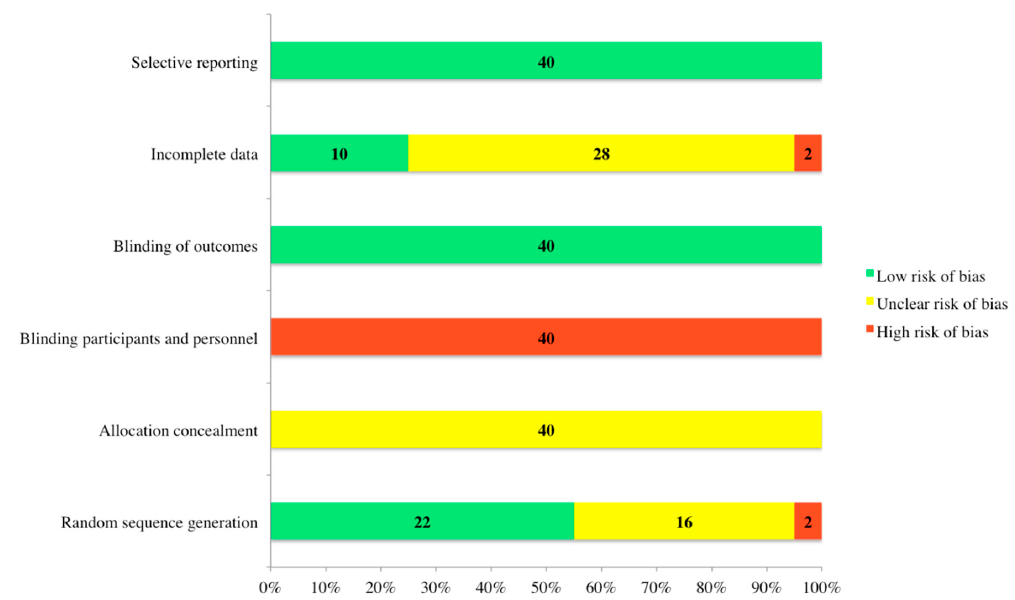
Figure 2. Results of the Cochrane risk of bias analysis conducted on all studies by two trained observers.